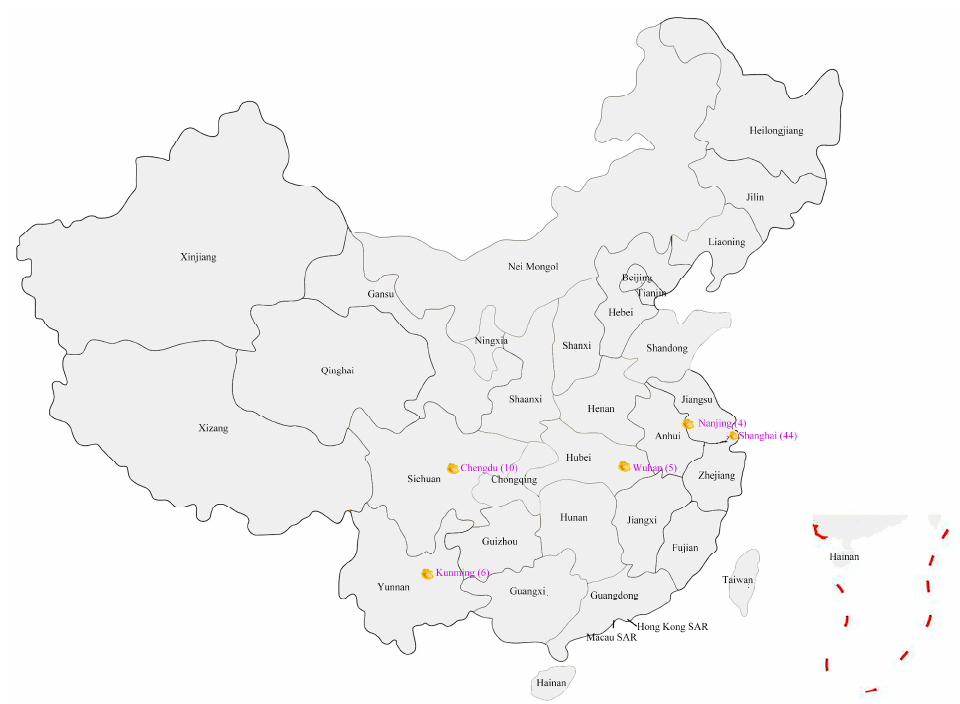
Figure 1. Distribution of sampling sites. Purple font represents sampling sites, and number of samples are indicated in parentheses. Black font represents the name of the provincial capital. Table 1. Summary of wintersweet cultivars and genotypes used in the study. Sampling